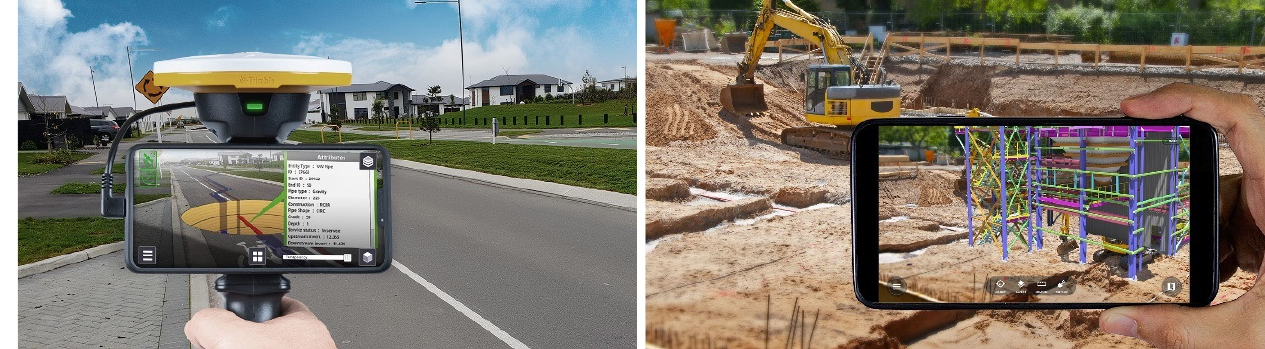
Figure 5. Trimble SiteVision AR system ( left ) and smartphone-based AR ( right ).